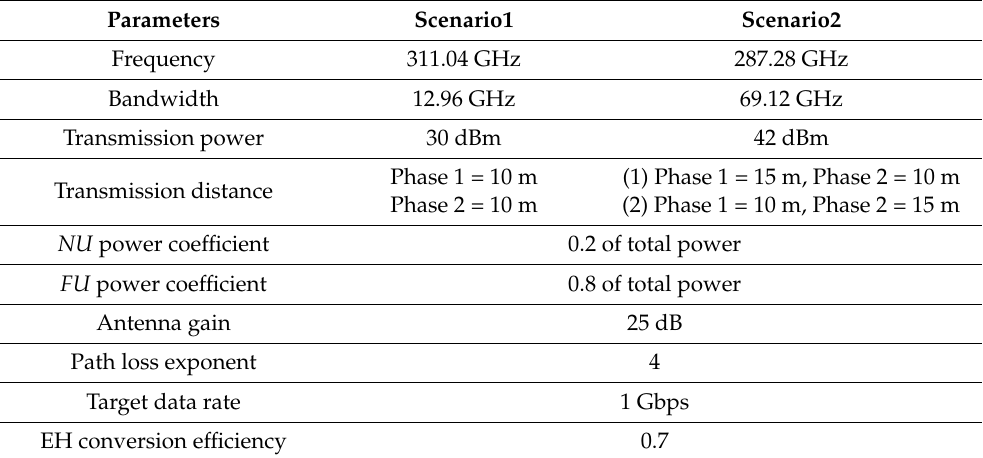
Table 1. Simulation parameters.